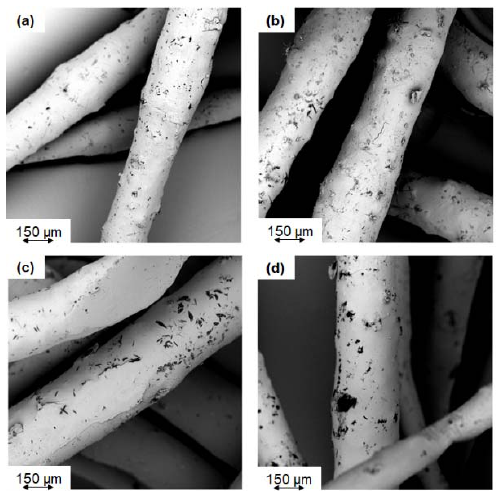
Figure 7. Scanning electron microscope (SEM) images of ( a ) PLA / OS1 / APP10, ( b ) PLA / OS3 / APP10, ( c ) PLA / OS5 / APP10 and ( d ) PLA / OS7 / APP10 multifilament fibers (PLA = polylactic acid; OS = oxidized starch; APP = ammonium polyphosphate).